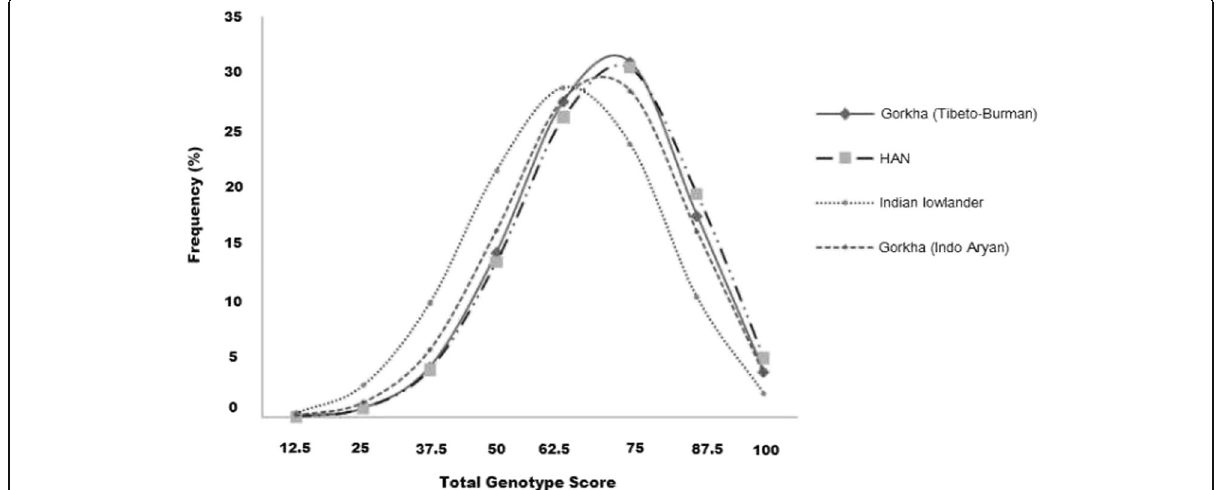
Fig. 2 Frequency distribution of total genotype scores (TGS) derived from dataset of 100,000 randomly generated individuals of Indian lowlanders (IA), high-altitude native (TB), Gorkhas (IA) and Gorkhas